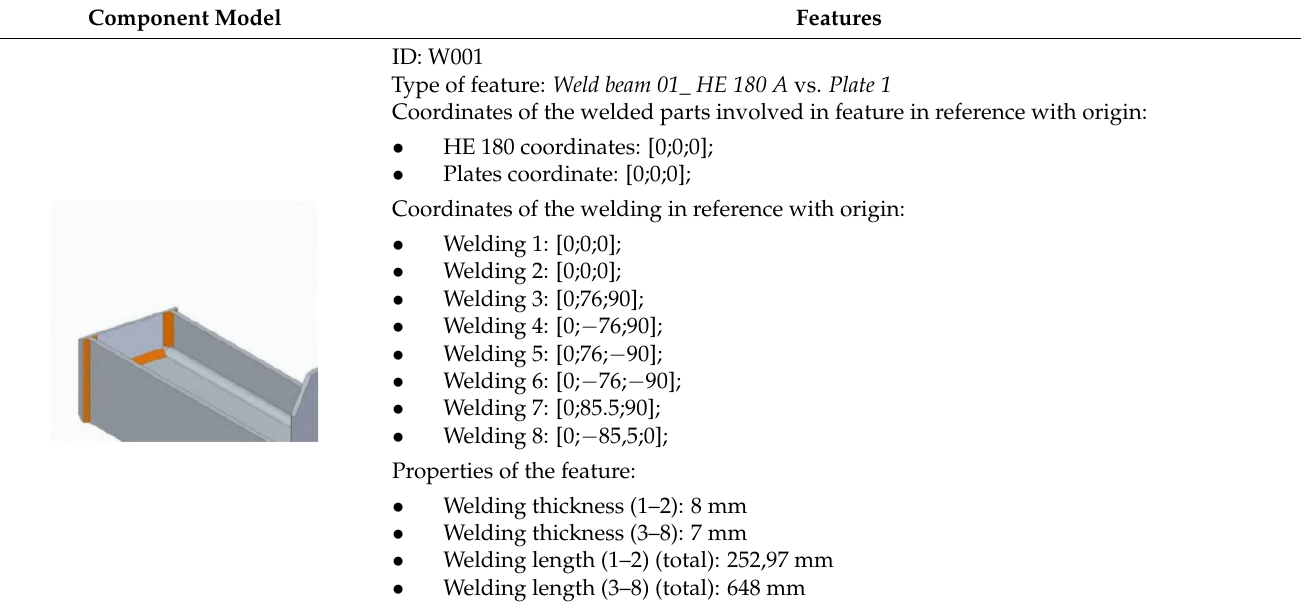
Table 6. Welding features (highlighted in orange) extracted by the 3D CAD model of the lateral frame. Component